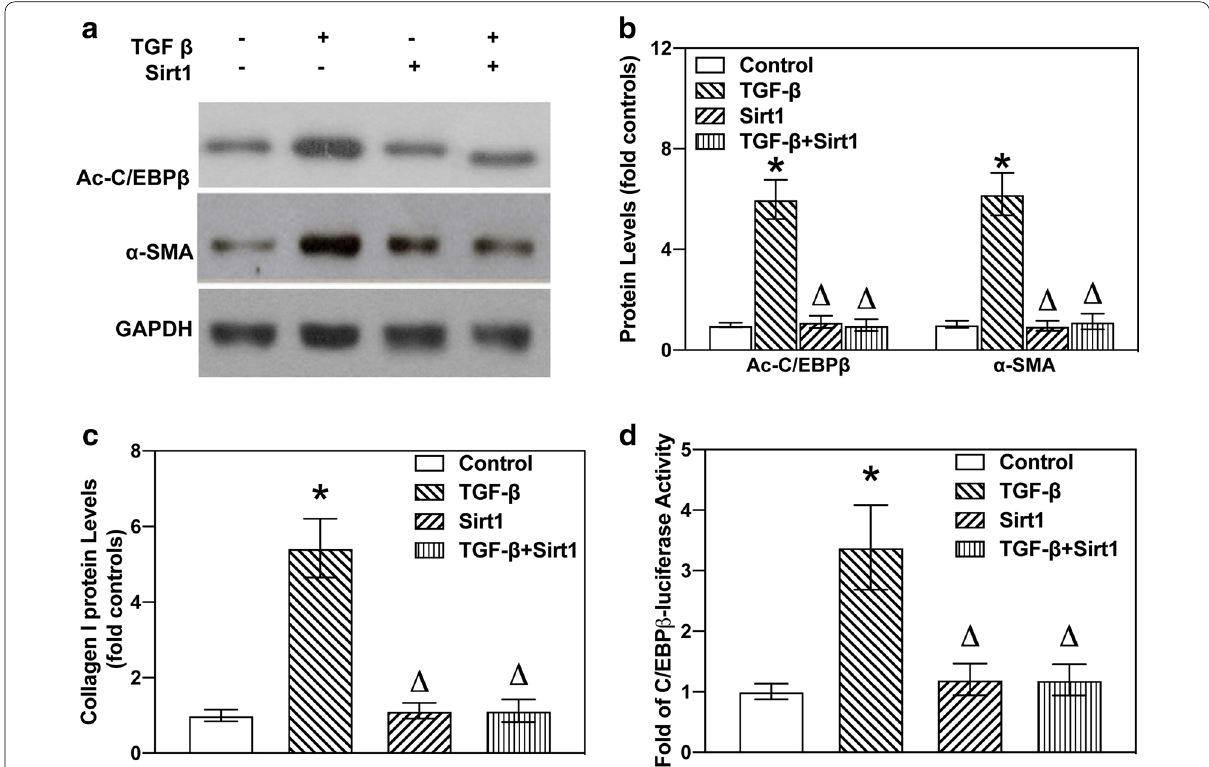
Fig. 6 Roles of C/EBPβ deacetylation in TGF-β-induced EMT and collagen deposition. a A549 cells were treated with TGF-β (10 ng/mL) for 24 h. Western blotting showing TGF-β treatment led to acetylation of C/EBPβ and increased the levels of α-SMA proteins. b Deacetylation of C/EBPβ via SIRT1 administered in A549 cells rectified TGF-β-induced elevation in collagen-I deposition. c Quantification of western blots were calculated according to grey analysis. d SIRT1 suppressed the increased C/EBPβ-luciferase activity in TGF-β-treated A549 cells. Data show mean (*) denotes significant difference (P < 0.05) compared to the